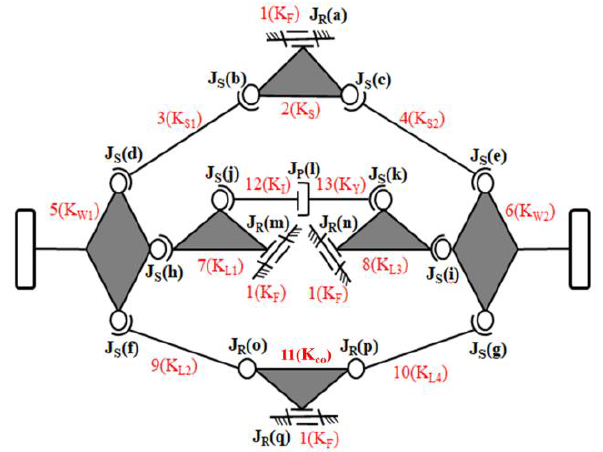
Figure 10. Atlas of the new steering tilting mechanism.